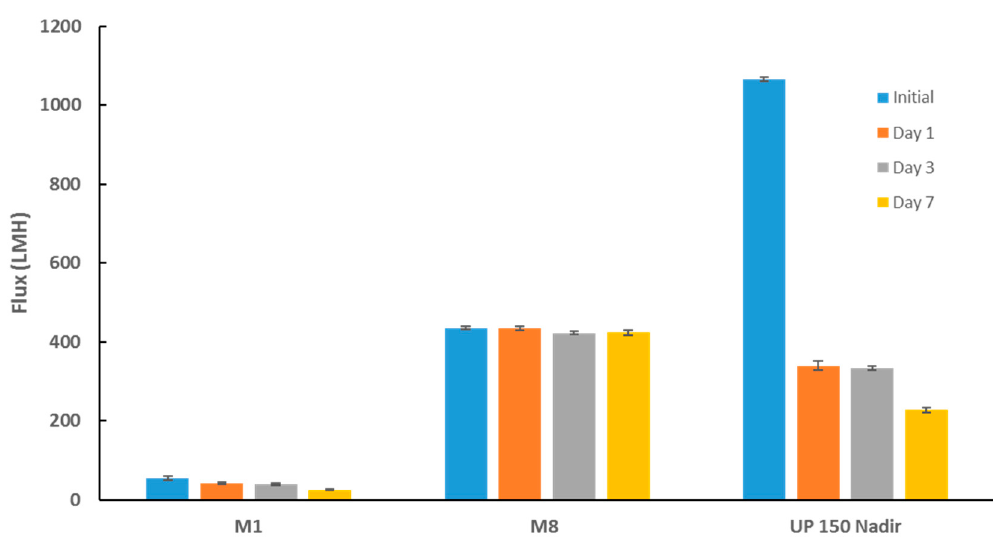
Figure 15. Membrane flux before incubation with bacterial suspensions and post incubation at different time points. Each bar represents the mean ± SD of three independent readings.